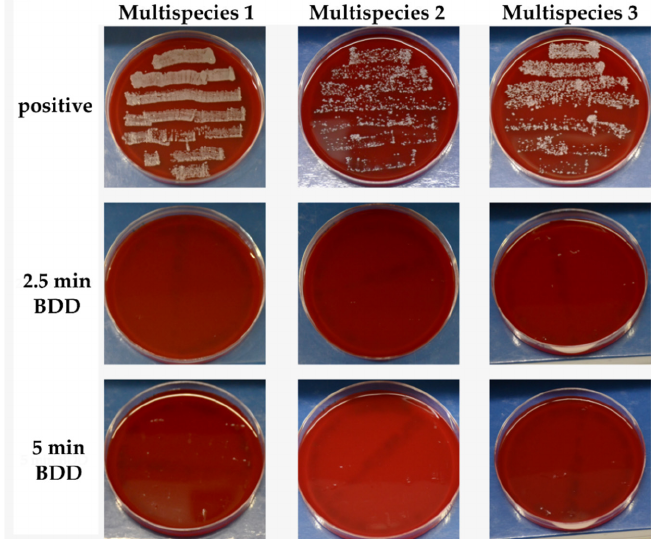
Figure 8. Standardized photographs of blood agar plates onto which the implants had been